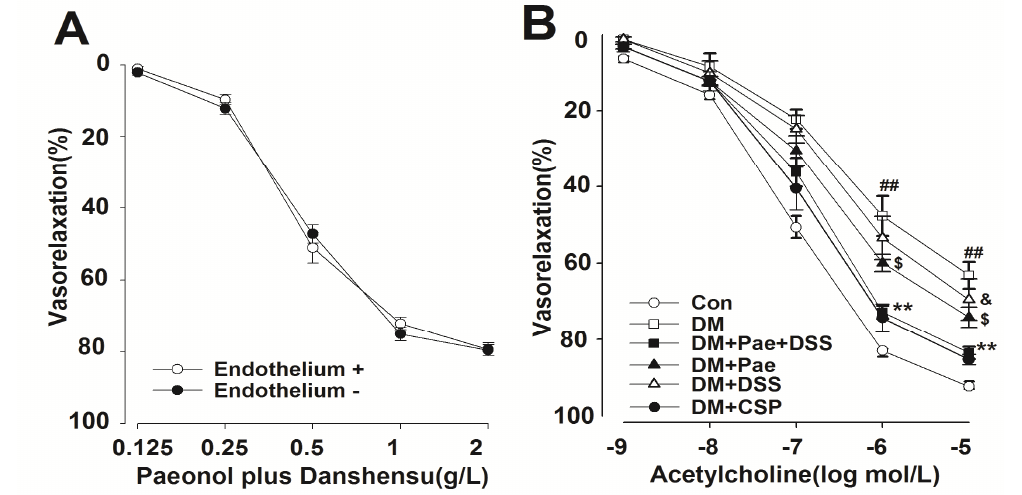
Figure 3. Concentration–response curves of Pae + DSS and ACh obtained in the rings of the cerebral artery of control and DM groups. ( A ) Pae + DSS induced relaxation in endothelium-intact (E+) or denuded (E − ) aortic rings from normal rats ( n = 5); ( B ) ACh-induced relaxation in all groups with functional endothelium ( n = 6): ** p < 0.01 compared with the corresponding DM group, ## p < 0.01 compared with the corresponding control group, $ p < 0.05 compared with the corresponding DM group, and & p < 0.05 compared with the corresponding DM group. Results are given as the mean ± standard error of the mean (SEM) of three independent